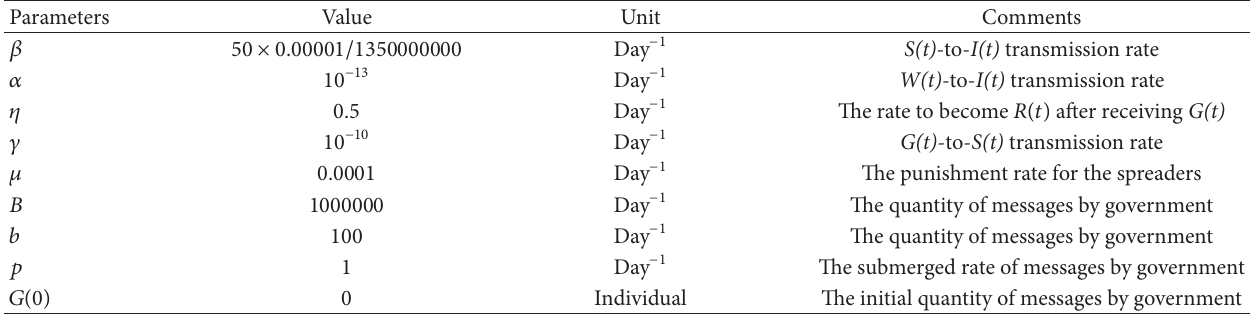
Table 3: Description of parameters in the system